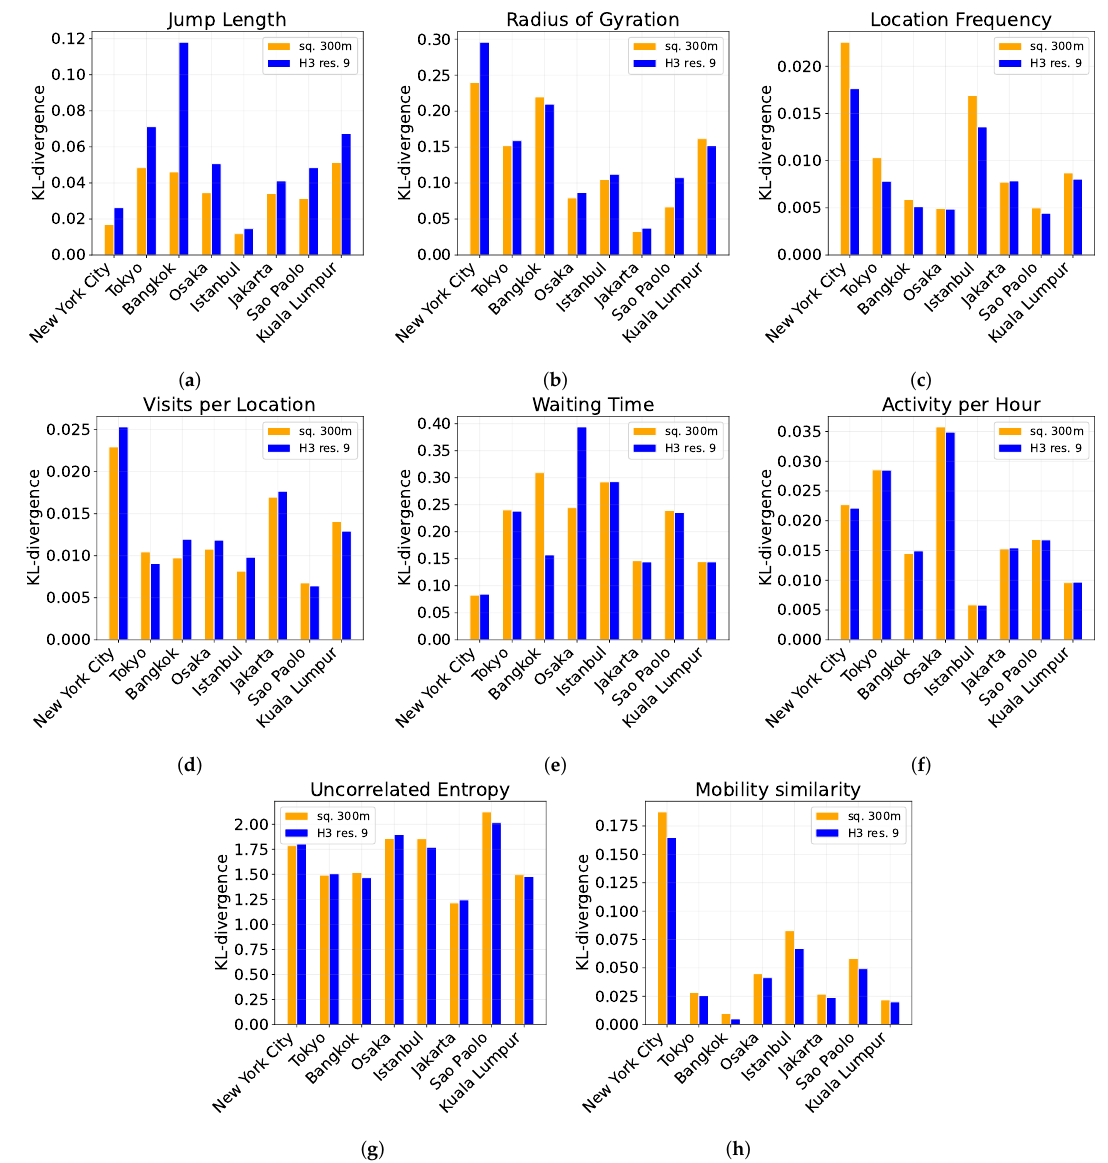
Figure 7. Average KL divergence of STS-EPR for jump length ( a ), radius of gyration ( b ), location frequency ( c ), visits per location ( d ), waiting time ( e ), activity per hour ( f ), uncorrelated entropy ( g ), and mobility similarity ( h ). Each group of bars indicate a city (New York City, Tokyo, London, Chicago, Los Angeles, and Madrid), each coloured bar within refers to the spatial tessellation used during the